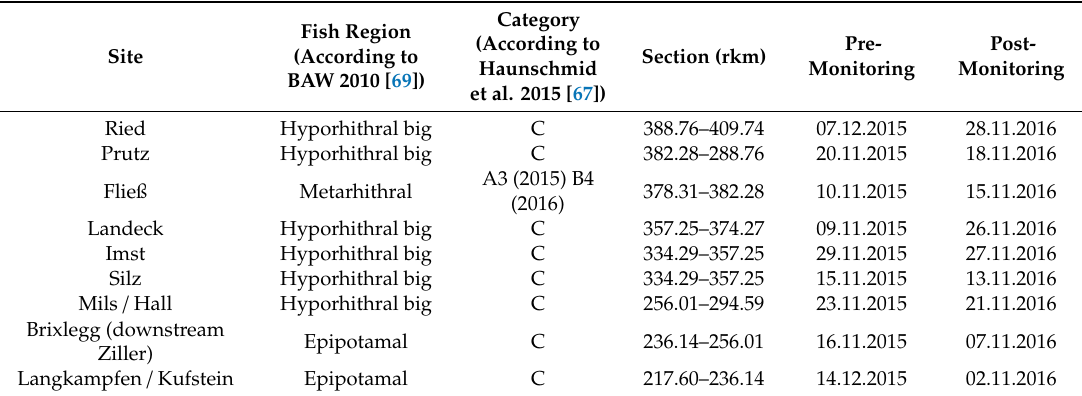
Table 1. Description of the various investigated sites including fish region, national classification, river length, and date of the pre- and